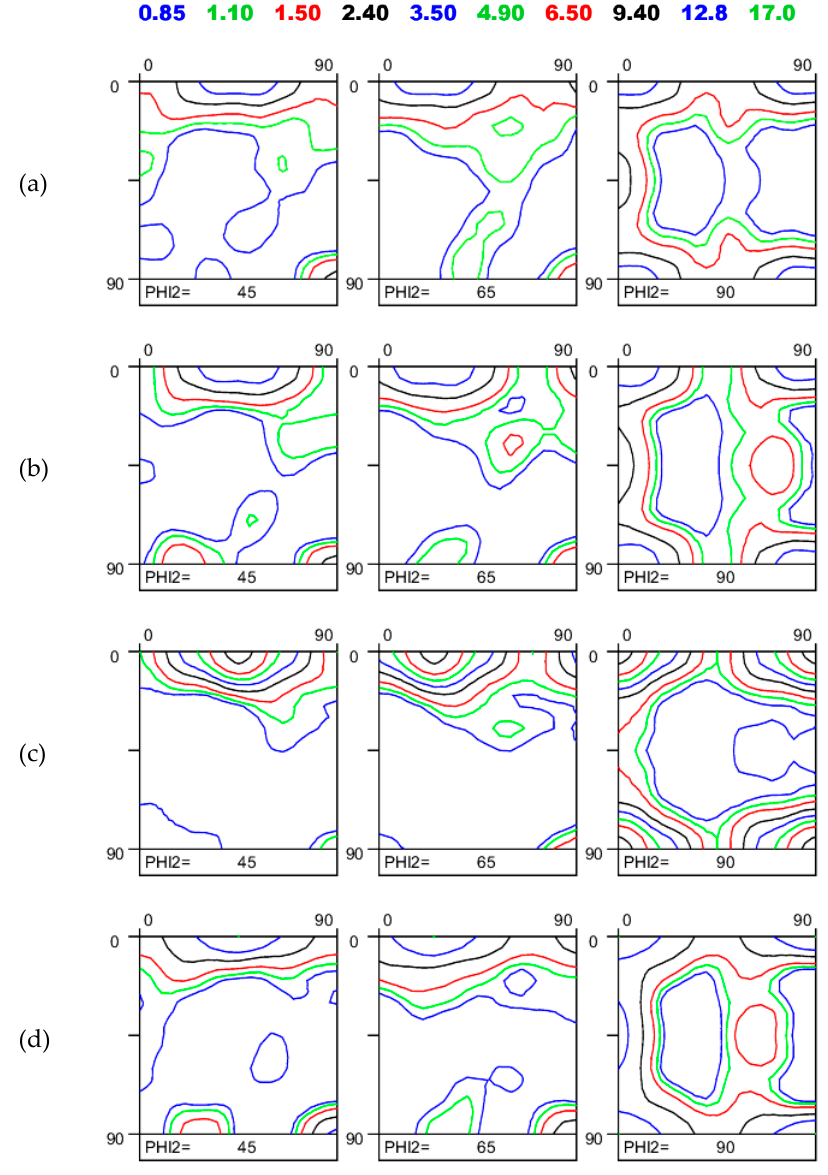
Figure 5. Recrystallization textures after annealing at 550 °C: ( a ) material A, ODF max = 4.23, TI = 1.26 ; ( b ) material B, ODF max = 4.39, TI = 1.36 ; ( c ) material C, ODF max = 11.03, TI = 2.12 ; ( d ) material D, ODF max = 4.92, TI = 1.46 .